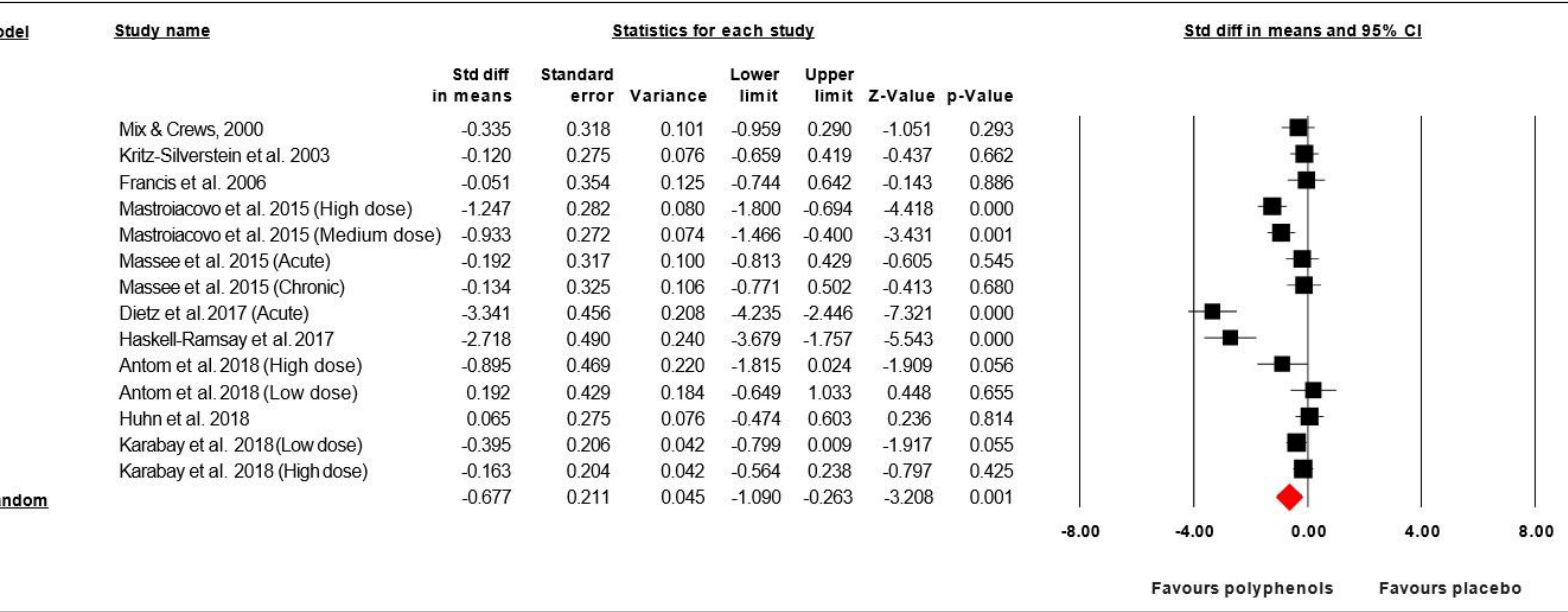
Figure 2. Forest plot of the standardized differences in means of the effect of (poly) phenols-rich supplementation on psychomotor functions. Note: A negative direction of effect size (ES) indicates a better effect of (poly)phenols-rich supplementation.